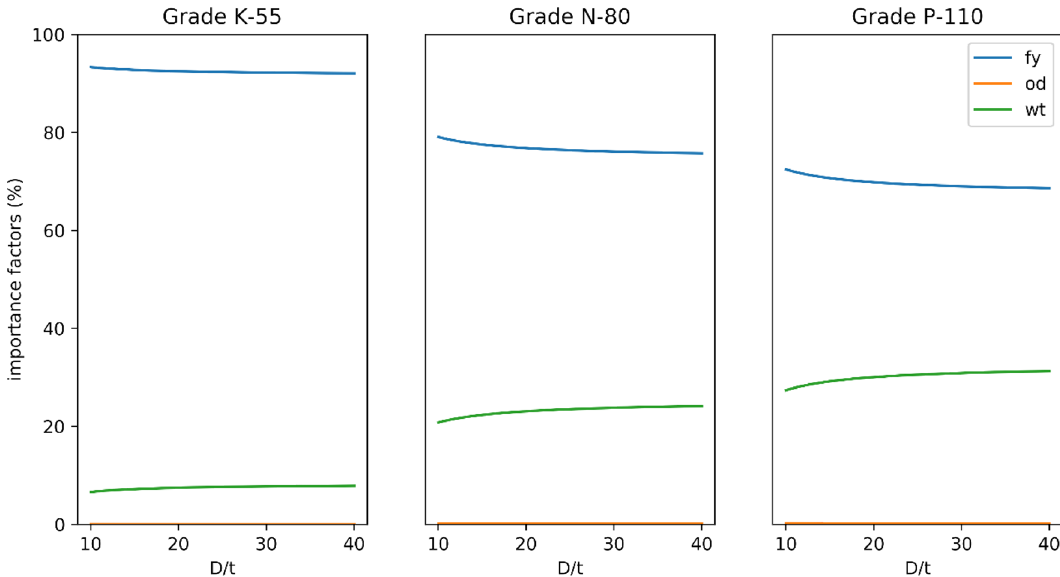
Fig. 9 Importance factors over D/t range for axial force